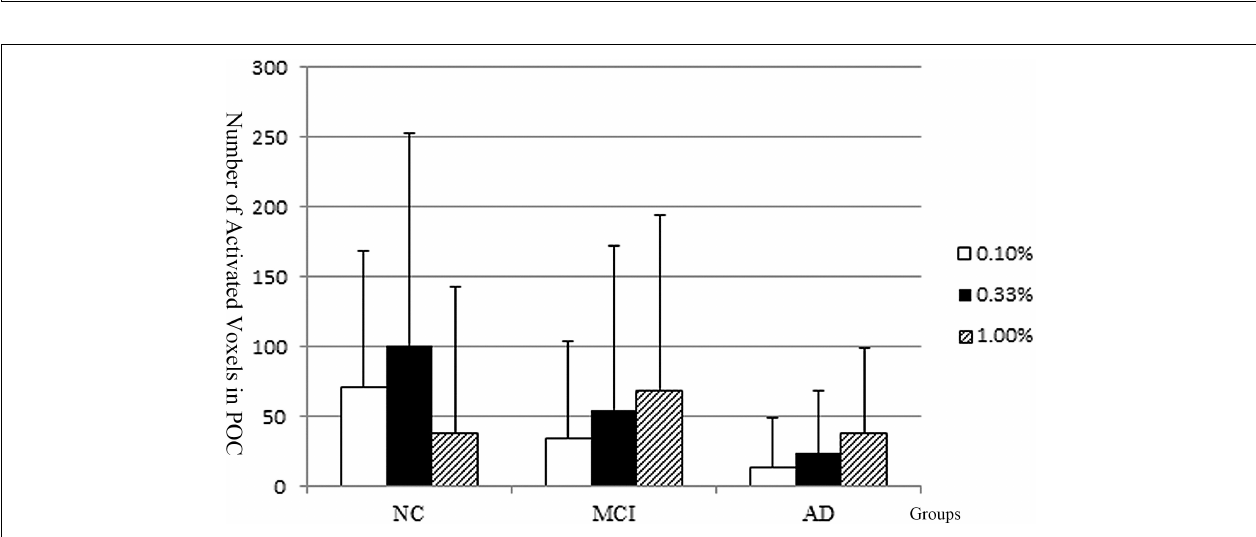
FIGURE 4 | The POC activation pattern across different concentration of the NC, MCI, and AD groups. The NC implied the normal olfactory habituation to the higher concentrations. The Alzheimer’s disease patients implied lacking of olfactory habituation. And the activation pattern of the MCI group is similar to the